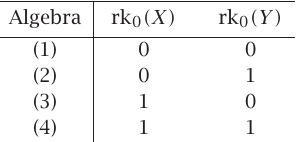
Table 1.1 . The rational toral ranks in M